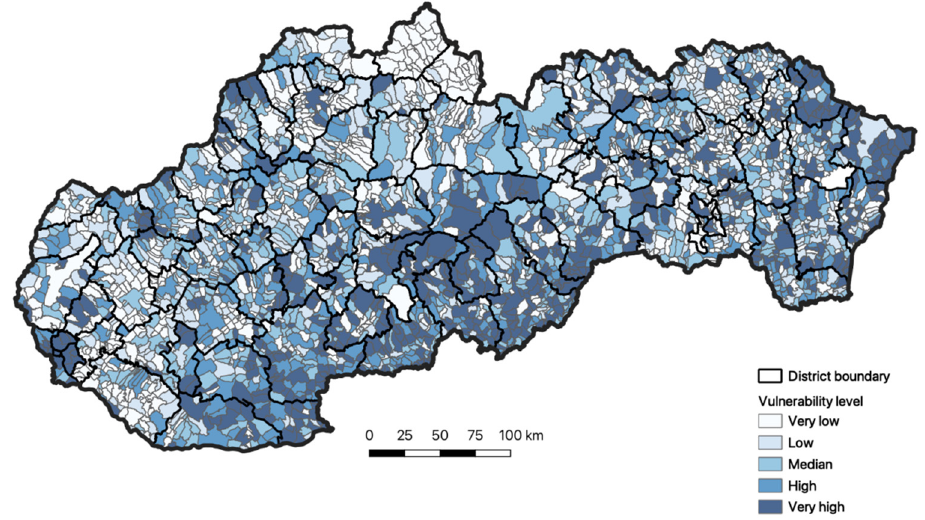
Figure 4. Vulnerability of the inhabitants of Slovakia toward respiration diseases. Source: Statistical Office of the Slovak Republic, 2020.